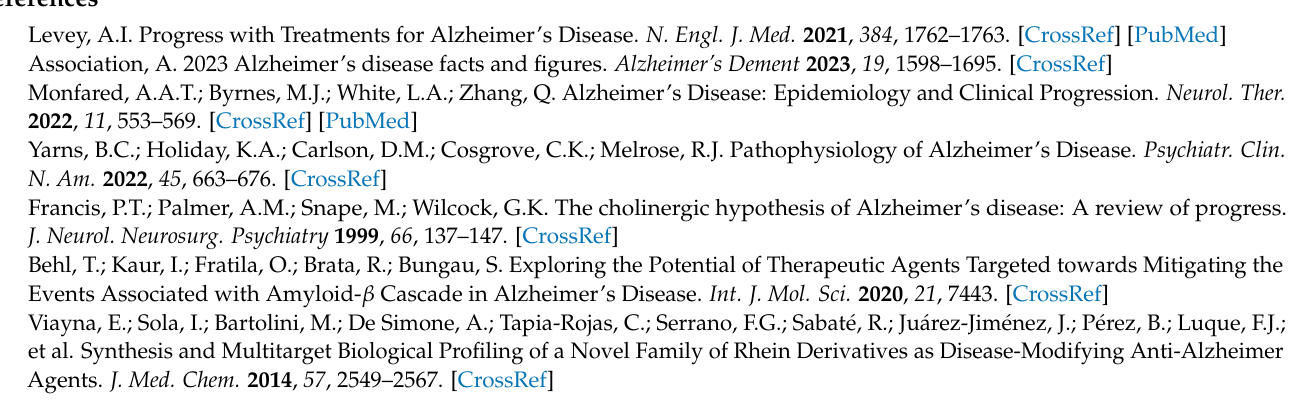
Table S3. Molecular descriptors of CART and CHAID models for predicting AChE inhibitory activity. Table S4. Molecular descriptors of CART and CHAID models for predicting BACE1 inhibitory activity. Figure S1. Variable importance according to RF models for predicting (A) AChE and (B) BACE1 inhibitory activity. Figure S2. Distribution of experimental IC 50 values of (A) 67 AChE inhibitors and (B) 144 BACE1 inhibitors among clusters. Table S5. Structures and bioactivities of 67 AChE inhibitors. Table S6. Structures and bioactivities of 144 BACE1 inhibitors. Table S7. Comparison of this study with previous published works on AchE. Table S8. Comparison of this study with previous published works on BACE1. Citation: